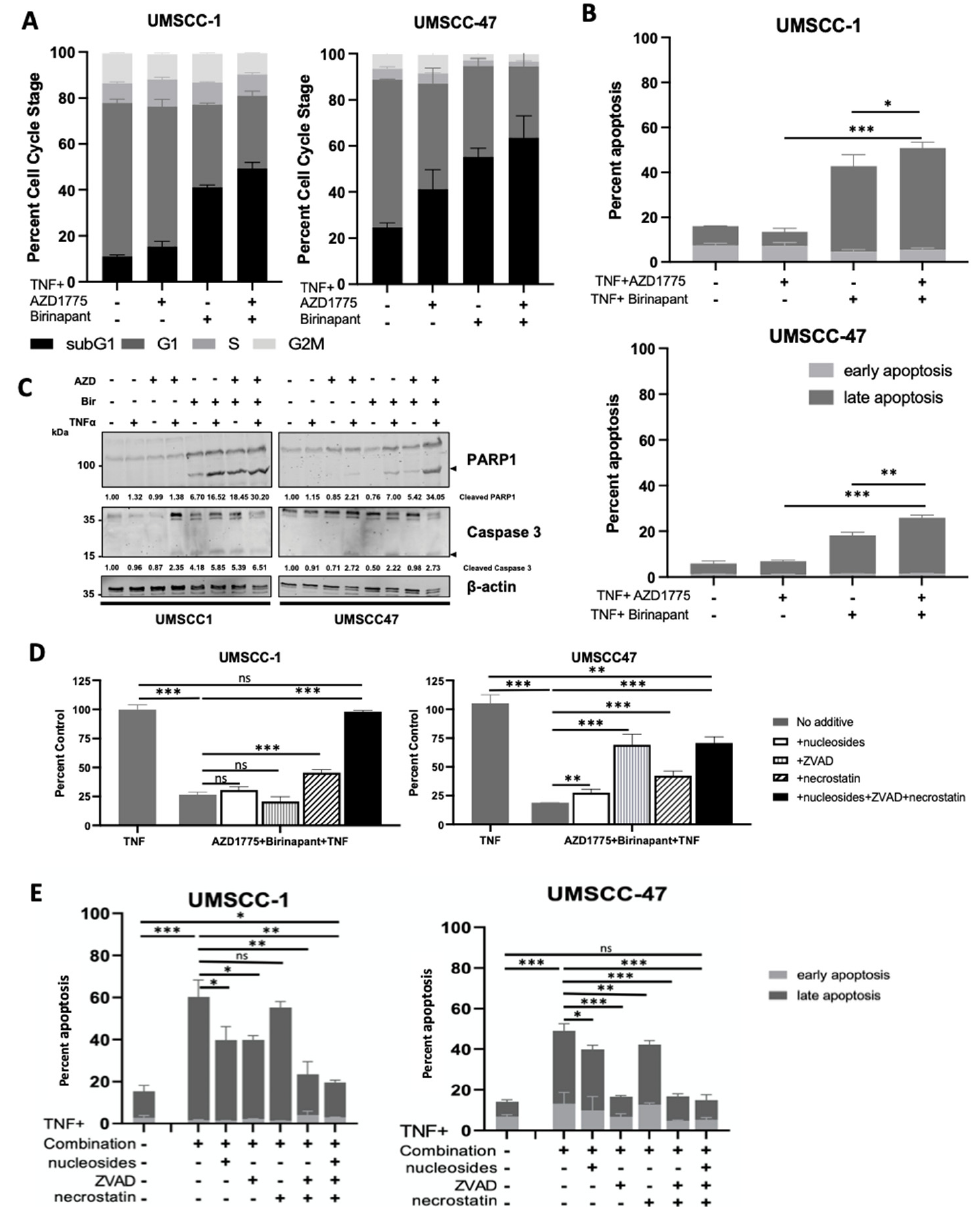
Figure 2. Combination treatment induces cell death in HNSCC through activation of multiple death pathways. ( A ) Cell cycle and ( B ) Annexin apoptosis assay analysis at 48 h after treatment. AZD1775/Birinapant = 100 nM, TNF = 20 ng/mL; n = 3. ( C ) Representative Western blot analysis of PARP and uncleaved/cleaved Caspase 3 expression following 48 h drug treatment. AZD1775 = 500 nM, birinapant = 500 nM, TNF = 20 ng/mL. β -actin was used as a loading control. ( D ) XTT viability assay at 72 h following simultaneous treatment with 500 nM AZD1775/Birinapant in the presence of 20 ng/mL TNF +/ − 20 uM necrostatin, 20 uM Z-VAD-FMK, 1x nucleosides supplementation. n = 3. ( E ) Annexin apoptosis assay at 24 h following simultaneous treatment with 500 nM AZD1775/birinapant in the presence of 20 ng/mL TNF +/ − 20 uM necrostatin, 20 uM Z-VAD-FMK, 1x nucleosides supplementation. n = 3. ns = not significant; * p < 0.05; ** p < 0.01; *** p <